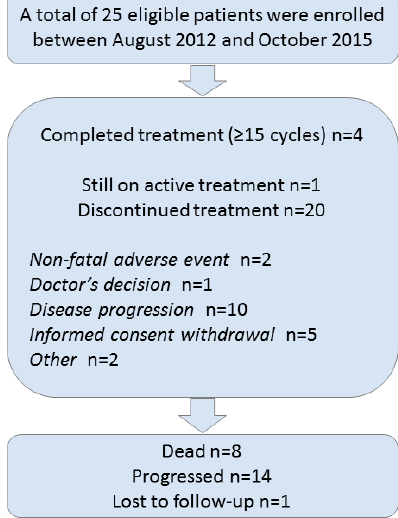
Figure 1. A Remark diagram.